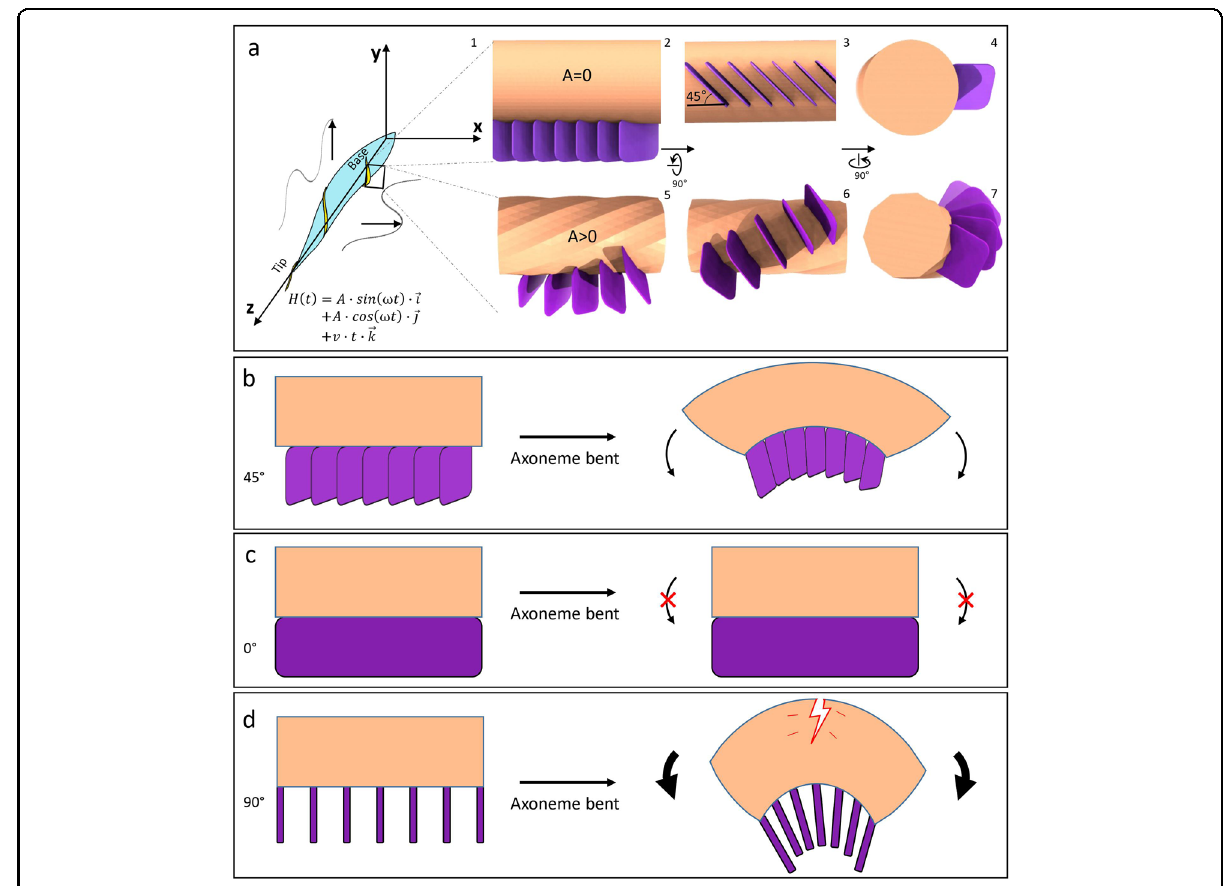
Fig. 7 Model for SSN planes supporting non-planar helical wave of the T. brucei fl agellum. a Schematics depicting movement of the T. brucei cell with the fl agellum ’ s non-planar helical wave decomposed into x , y , and z components (left, a 1 ). ~ i ;~ j ;~ k are unit vectors along x , y , and z axis, respectively. The right panels (a 2 – 7 ) show the architectural relationship between the axoneme (tan) and SSN planes of the PFR (purple) on the fl agellum in the resting (amplitude A = 0) and beating ( A > 0) states. Note that non-planar helical wave would introduce local twist to the fl agellum (a 5 – 7 ). b – d Three different axoneme bending scenarios with SSN planes placed at either 45° (observed, b ), or hypothetically, 0° ( c ) or 90° ( d ), with respect to the axoneme